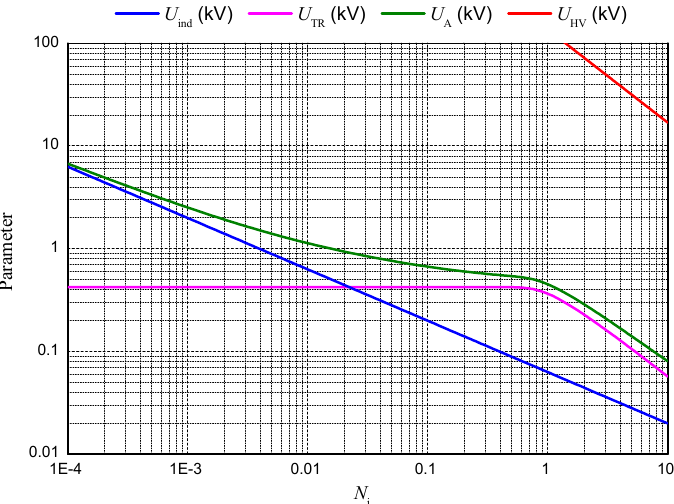
Figure 7. Trend of the voltage components that build up the voltage U A for LV circuits in conduit.